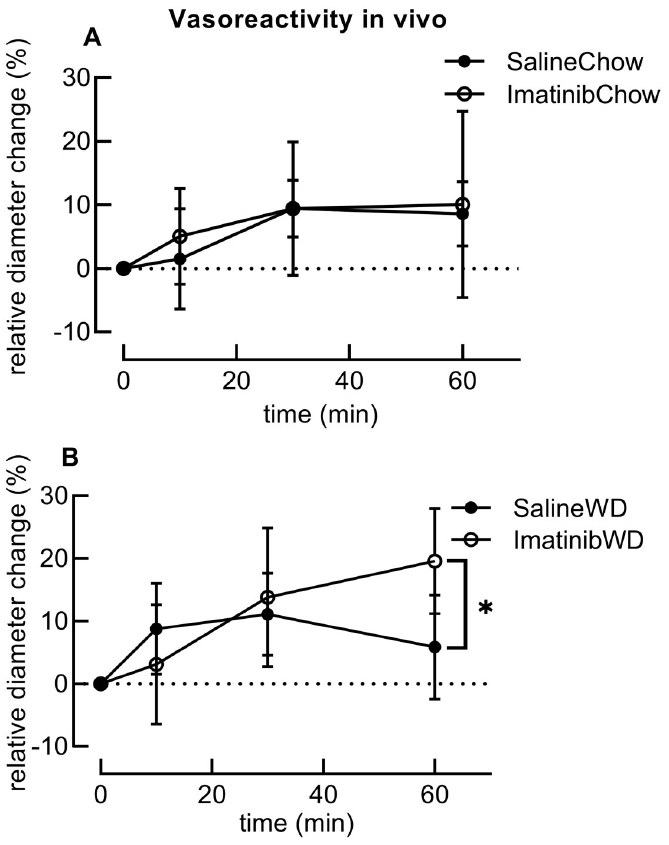
Fig 2. Vasoreactivity of the gracilis artery in response to insulin, measured with intravital microscopy. A: Imatinib does not affect insulin-induced vasoreactivity in vivo in mice fed a chow diet. B: Imatinib increases insulin-induced diameter change at t = 60 minutes in mice fed a Western diet (WD). � P < 0.05 as tested with unpaired T-test; n = 4–8 per